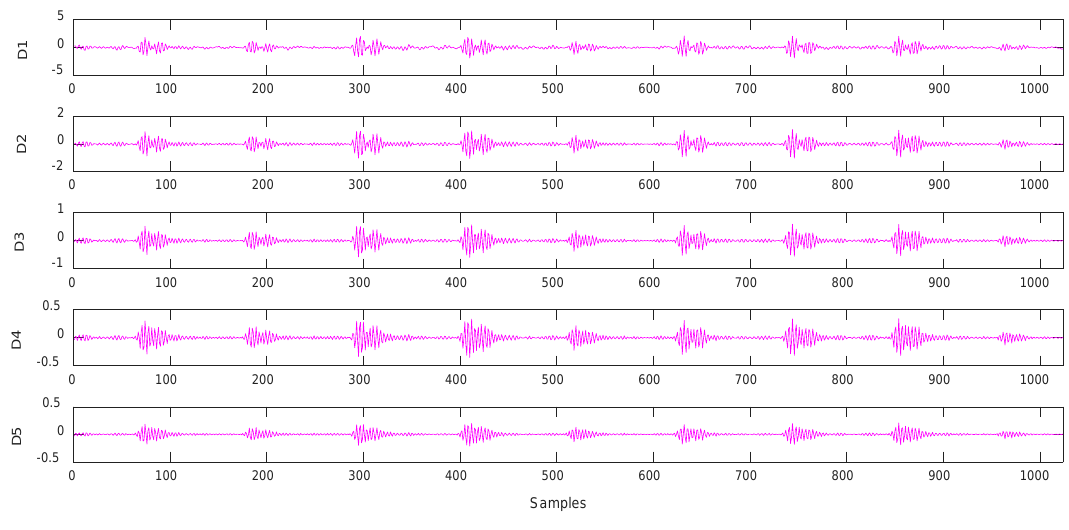
Figure 10. MRSVD breakdown detail signal.